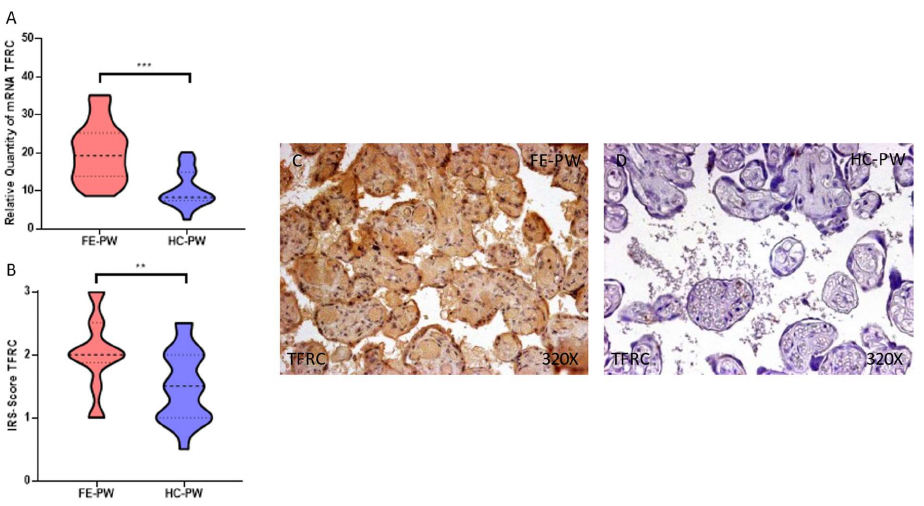
Figure 2. ( A ) TFRC mRNA expression in both the FE-PW (first episode of psychosis in pregnancy) and HC-PW groups (healthy controls). ( B ) IRS-Scores for TFRC expression in the placenta villi of the FE-PW group and the HC group. ( C , D ) Images showing the immunostaining for TFRC in the placenta villi of the FE-PW group and the HC-PW group. p < 0.01 (**), p < 0.001 (***).